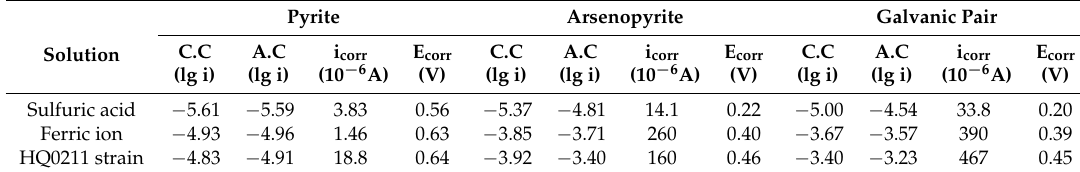
Table 2. The calculated Tafel curve data of pyrite, arsenopyrite, and the galvanic pair in the investigated solutions (C.C.: Cathode Current; A.C.: Anode Current; i corr : Corrosion current; E corr : Corrosion